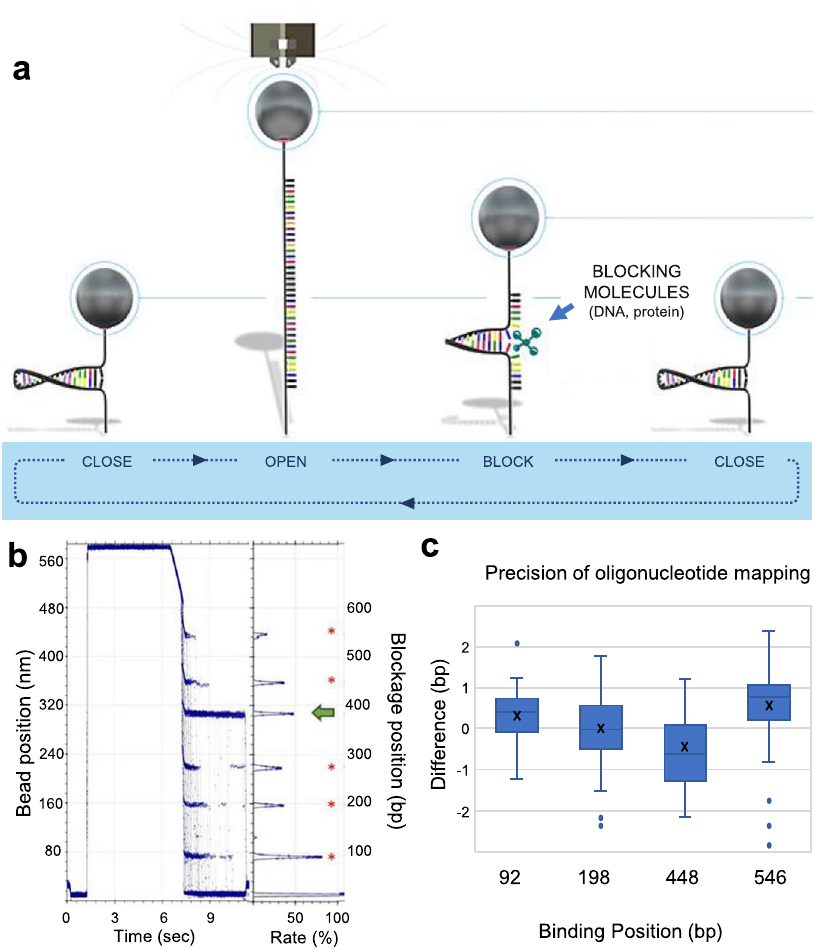
Fig. 1 Analytical approach and precision of the new MT platform. a Schematic representation of a typical MT cycle. When the force increases, by approaching the magnets to the sample, the DNA hairpin molecule is denatured and binding molecules (either oligonucleotides or proteins) bind to the ssDNA nucleic acid. Upon reduction in force, the hairpin reforms and transient blockages occur at the binding positions. b All the cycles are overlaid, and a cumulative histogram of the blocking positions is built. In this example, a 11-base reference oligonucleotide that binds fi ve times (red asterisks) was injected at the same time as an antibody against m 5 C modi fi cation (green arrow). c Mapping of reference blocking positions of a 11 DNA base oligonucleotide on a 600 bp hairpin ( n = 80 individual molecules). The average experimental positions versus the expected positions were between ±one base for the majority of the molecules. Whisker boxes represent 50% of the points with the average as a line within the box and the median as a